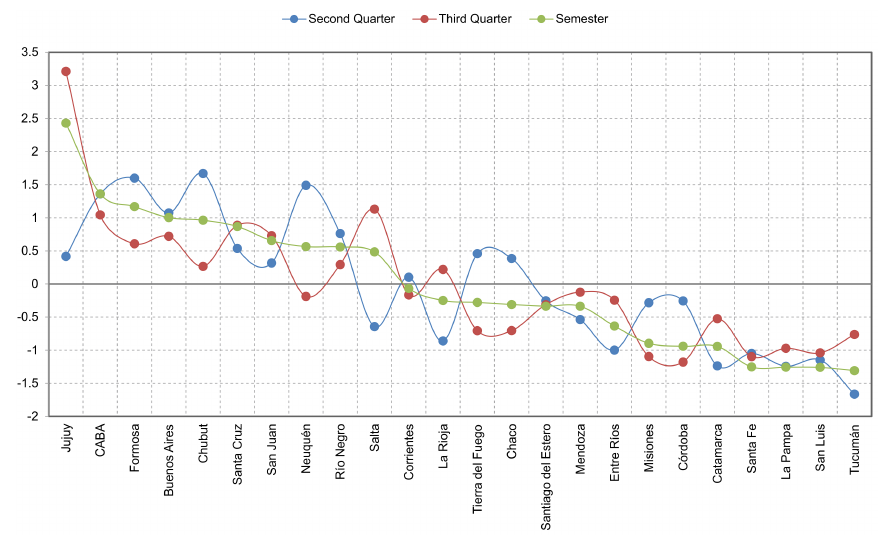
Figure 2: ITEI for provinces: standardized values per quarter and